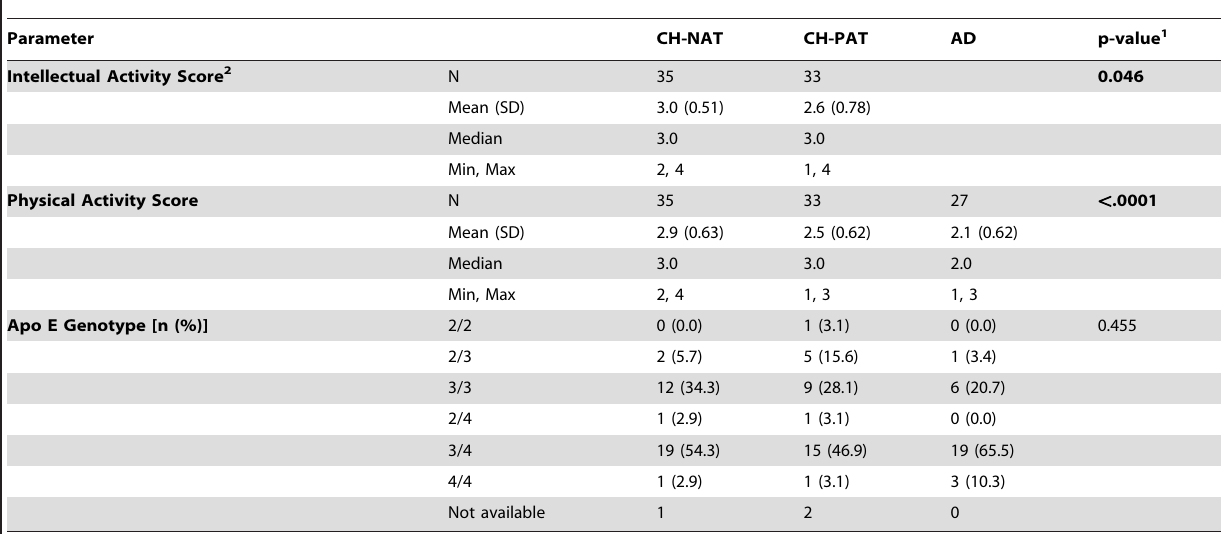
Table 2. Activity scores and Apo E genotype by clinical group.